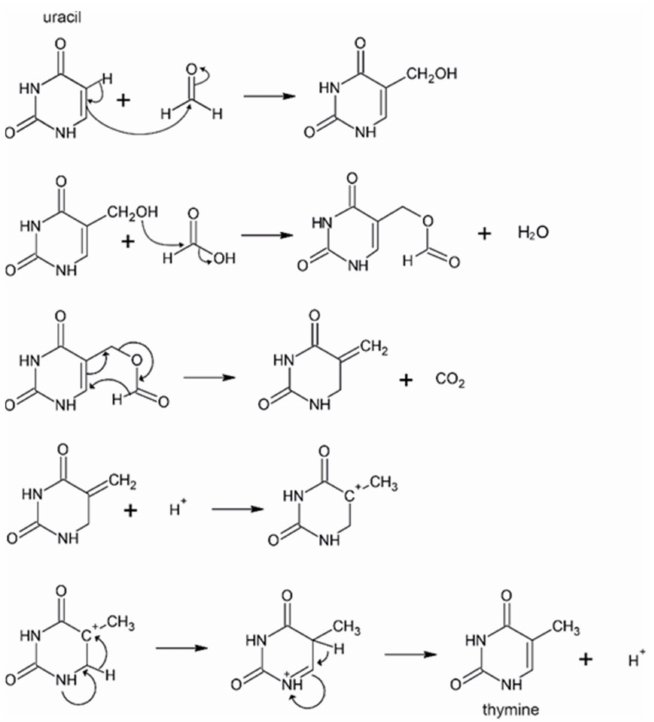
Figure 1. Suggested mechanism for the conversion of uracil to thymine in formamide from